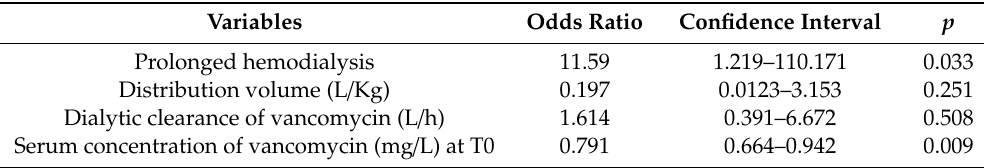
Table 6. Logistic regression of the variables associated to AUC / MIC <